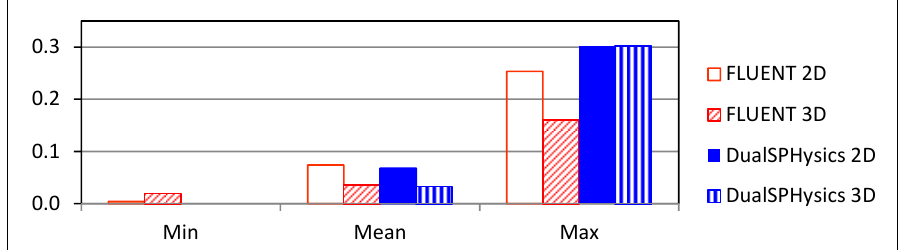
Figure 20. Minimum, mean, and maximum wave overtopping discharge (m 3 /s/m) over the dike for FLUENT and DualSPHysics with (3D) and without (2D) groins.